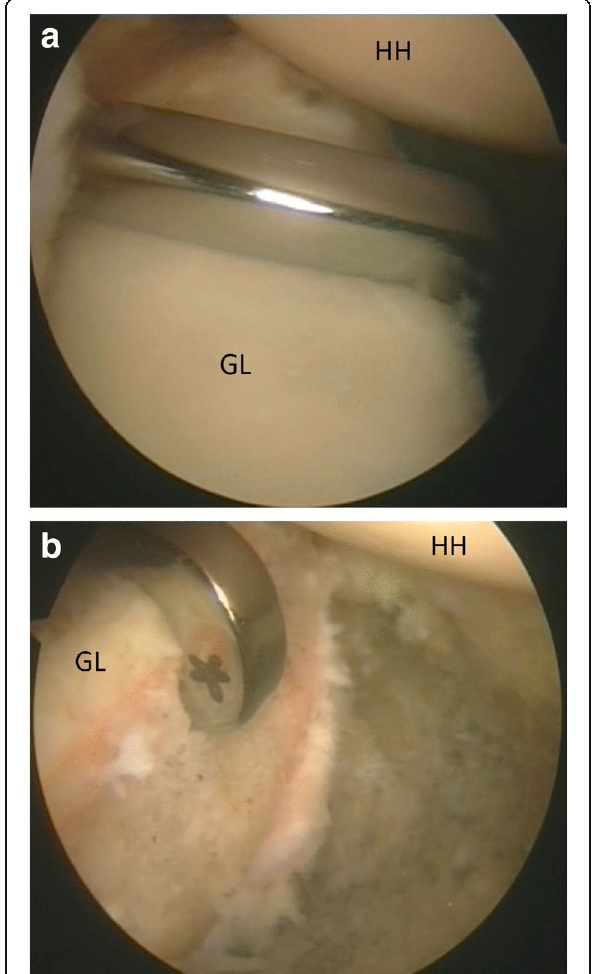
Fig. 1 Left shoulder, anterior on the right and posterior on the left, scope from antero-superior portal, hook guide from posterior portal. The Hook guide is parallel to the glenoid surface ( a ) and in the center of bone defect ( b ) (HH: humeral head, GL: